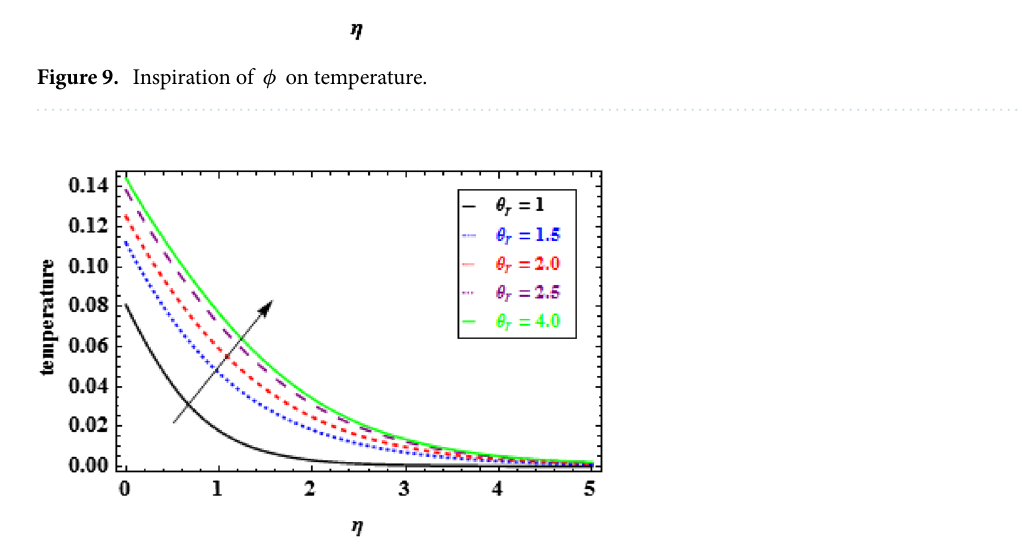
Figure 10. Inspiration of θ r on